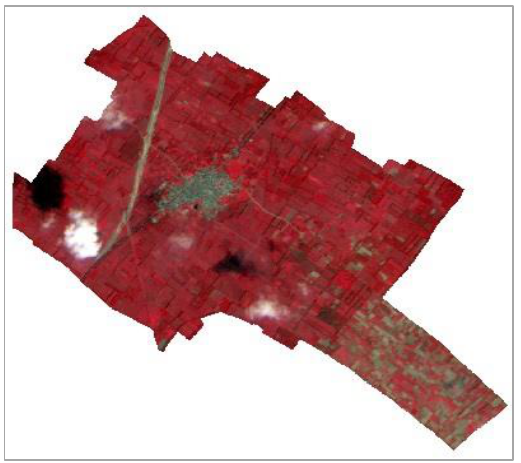
Figure 2. False colour composite image